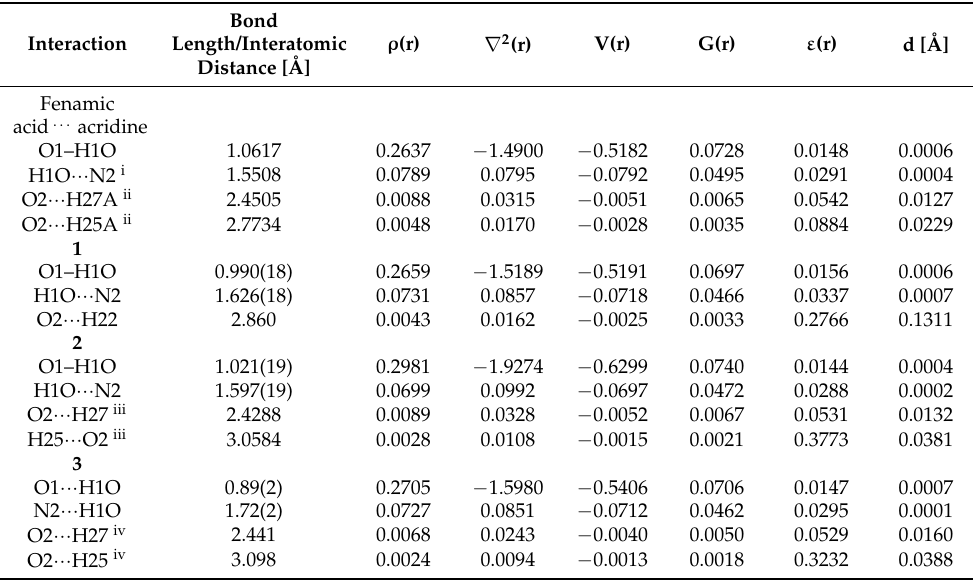
Table 3. QTAIM parameters for the BCPs. Symmetry codes: i = − x + 1, − y + 1, − z + 2; ii = x + 1,